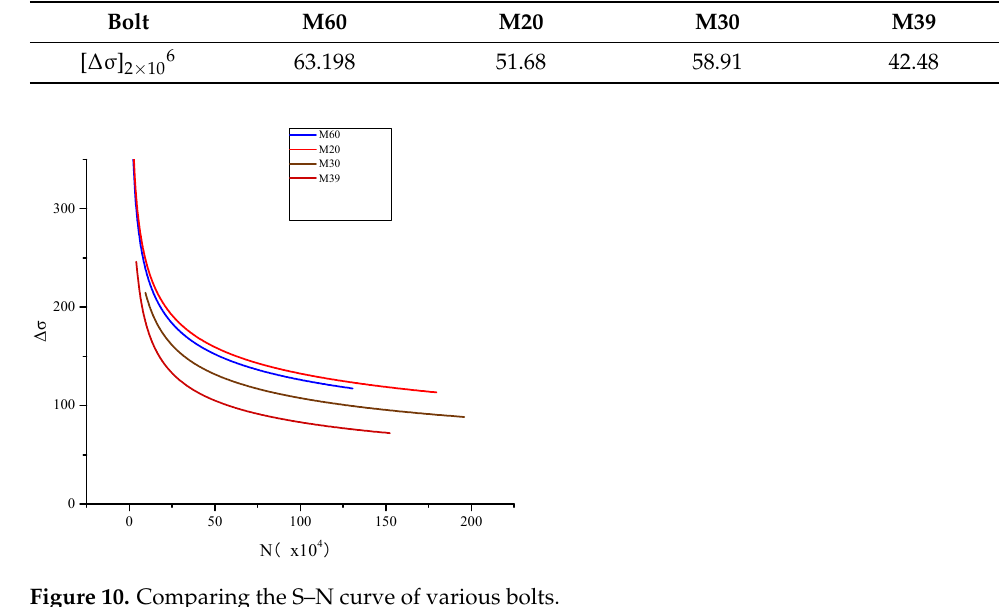
Figure 10. Comparing the S–N curve of various bolts.